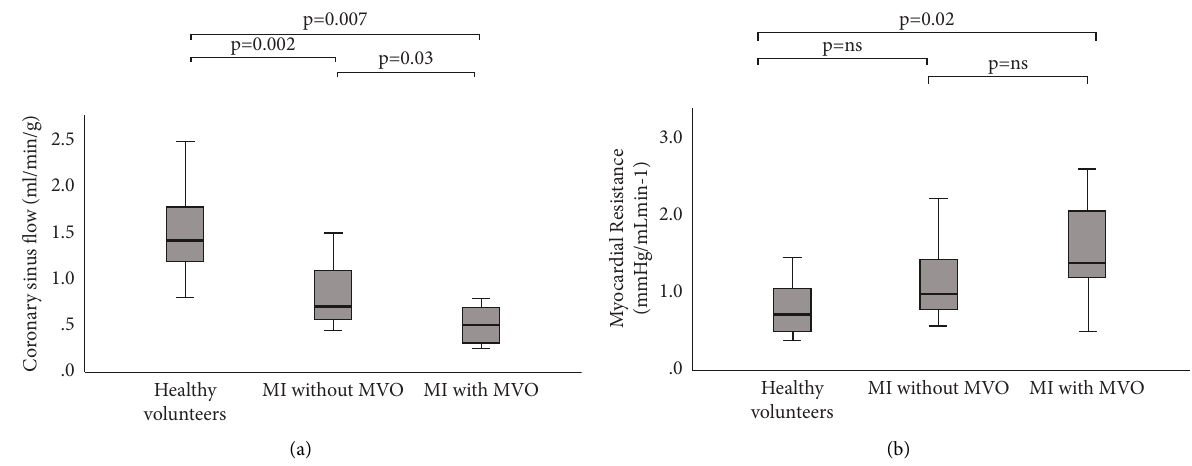
Figure 2: Coronary sinus fow stratifed by disease subgroup. Coronary sinus fow (ml/min/g) (a) and myocardial resistance (b) in healthy volunteers, MI without MVO and MI with MVO. Data shown as boxplots and whiskers indicating the minimum and maximum, and the boxes the 25 th and 75 th percentiles. MI � myocardial infarction ; MVO � microvascular obstruction.